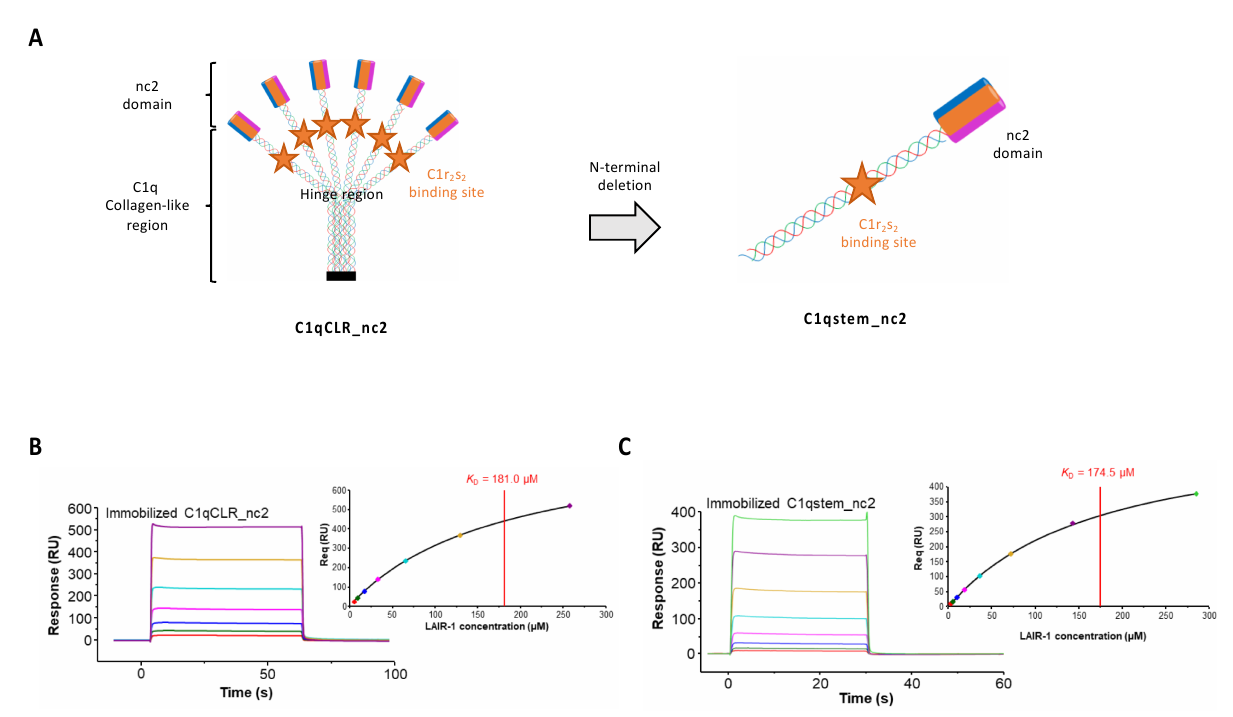
Figure 4. Analysis of LAIR-1 interaction with C1qCLR_nc2 and C1qstem_nc2. ( A ) Schematic representation of the full length C1qCLR_nc2 protein (left part) and C1qstem_nc2 fragment (right part), the C1r 2 s 2 binding site is represented with an orange star. ( B , C ) Soluble LAIR-1 Ig-like domain was injected at increasing concentrations over immobilized C1qCLR_nc2 ( B ) and C1qstem_nc2 ( C ). Fits obtained by a global fitting of the data to a steady-state model are shown in the top right corner of each panel. The results shown are representative of three experiments.